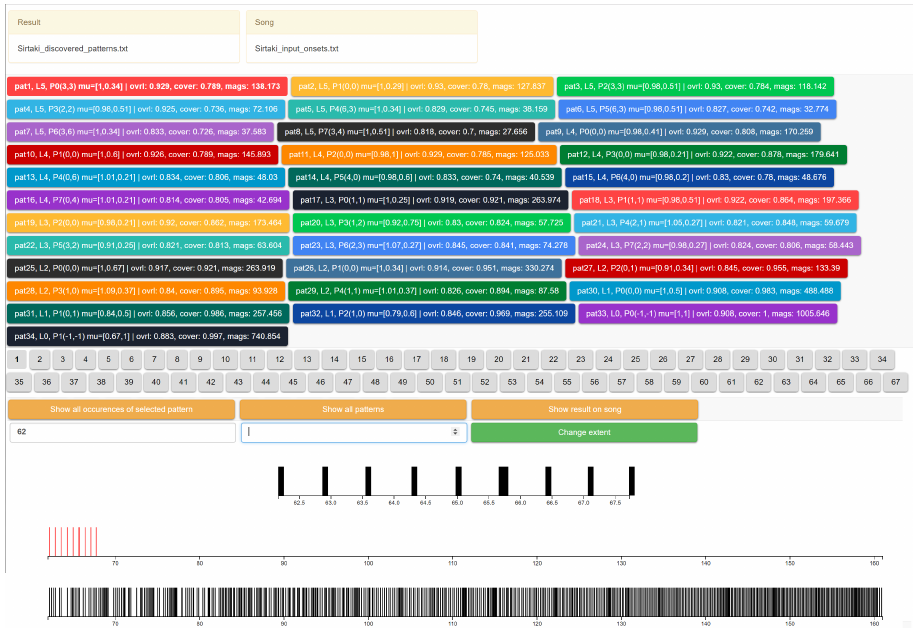
Figure 19. The web-based visualization of a model, showing a straight pattern and its occurrences in the input. Each part (assigned an individual color) is described by the composition of subparts and their offsets µ 1 , µ 2 , with some additional information, such as coverage of the input signal, self-overlapping of the activations and the amount of covered events in the input signal. Each individual part can be inspected by visualizing its structure and its projected activations onto the input visualization. The time-span (in seconds) of the projection can be narrowed to the segments of